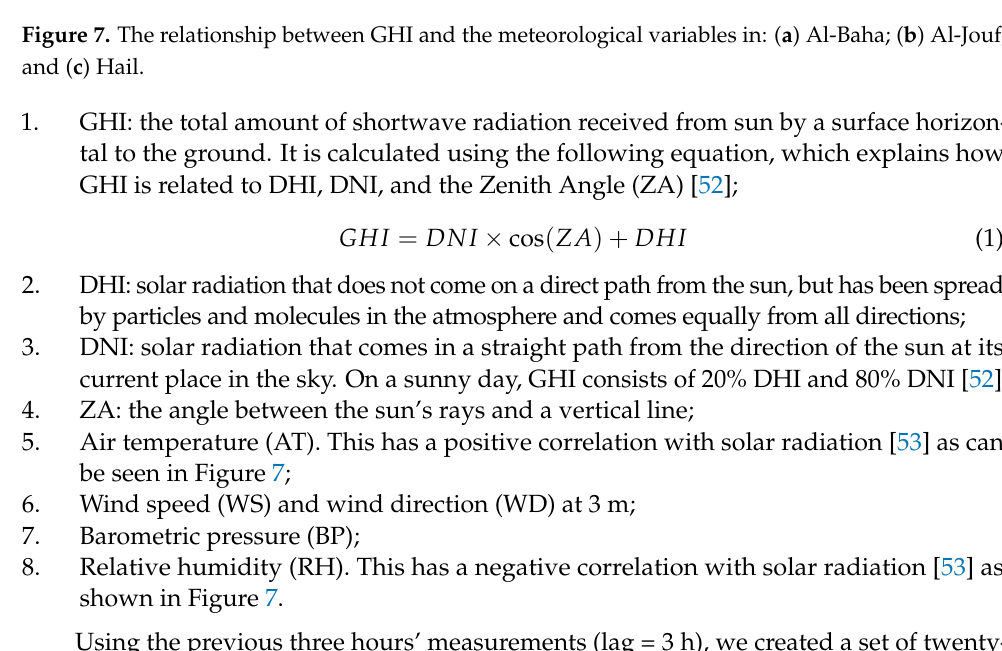
Table 5. Example of creating lagged features of GHI.